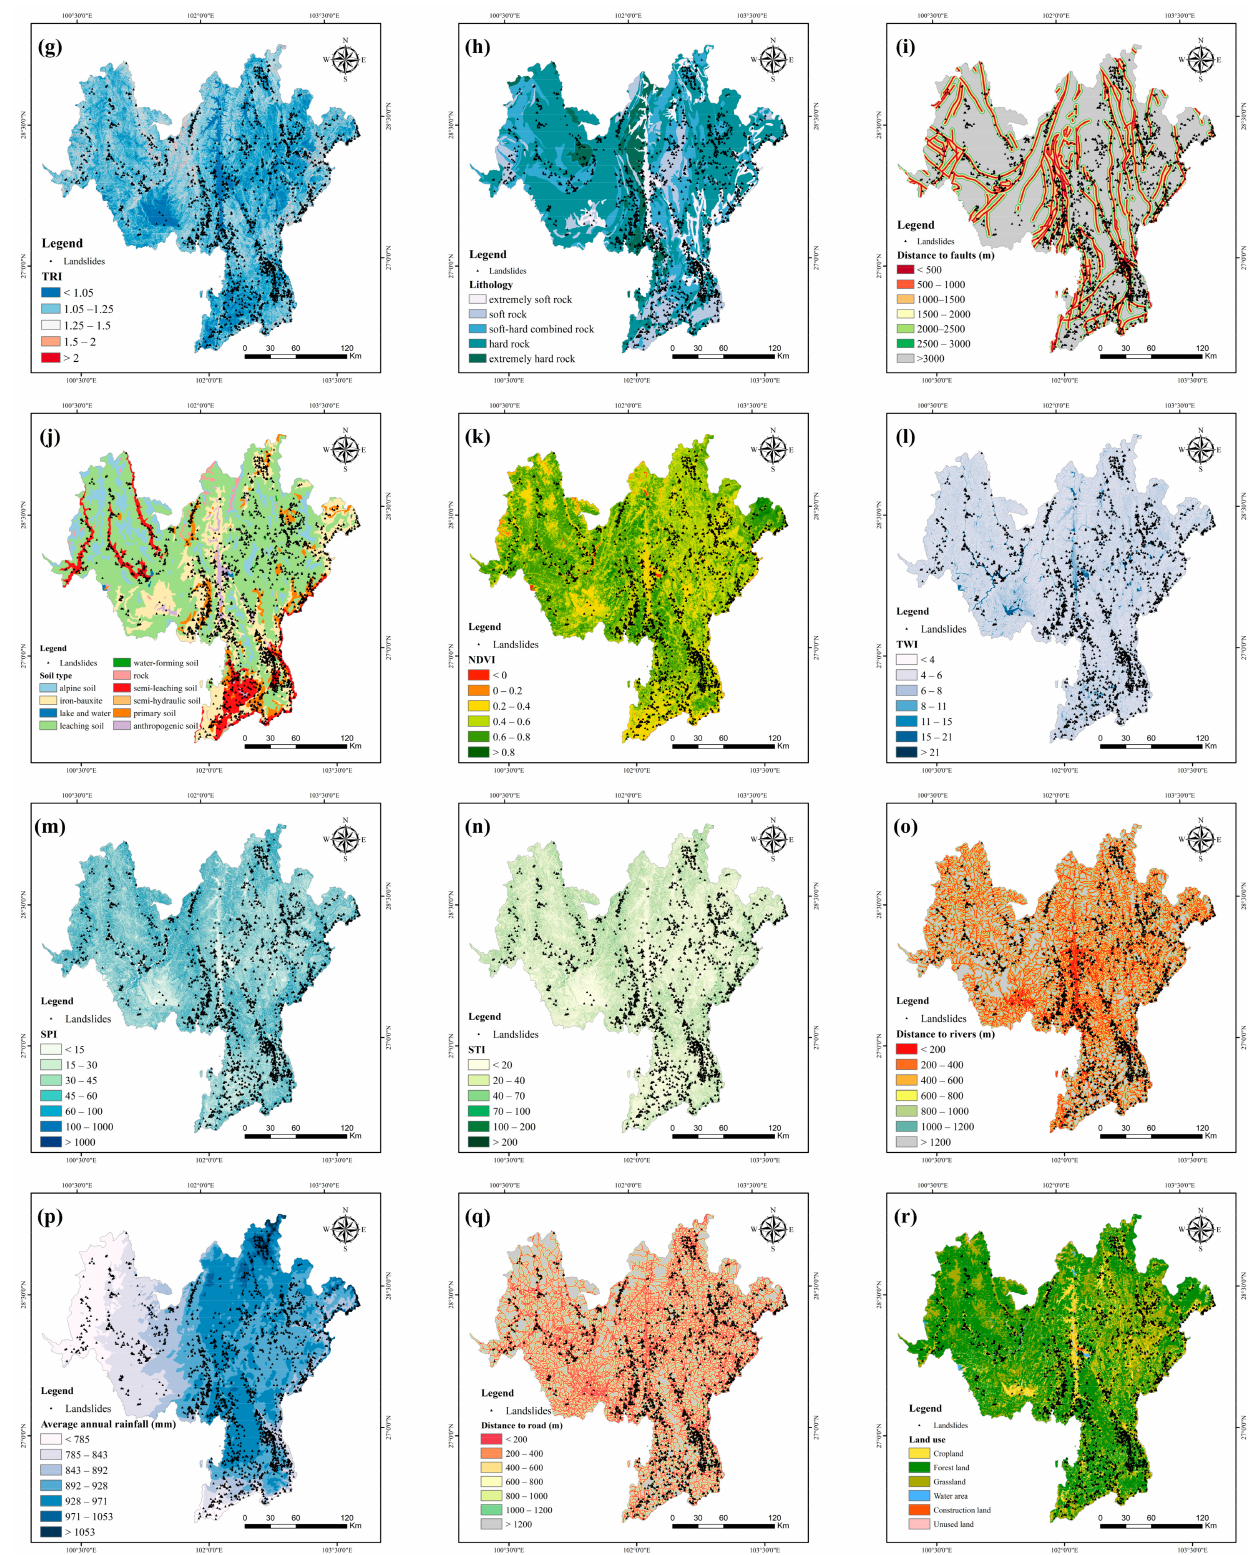
Figure 2. Landslide conditioning factors: ( a ) elevation; ( b ) slope angle; ( c ) slope aspect; ( d ) profile curvature; ( e ) plan curvature; ( f ) topographic relief; ( g ) TRI; ( h ) lithology; ( i ) distance to faults; ( j ) soil type; ( k ) NDVI; ( l ) TWI; ( m ) SPI; ( n ) STI; ( o ) distance to rivers; ( p ) average annual rainfall; ( q ) distance to roads; ( r ) land